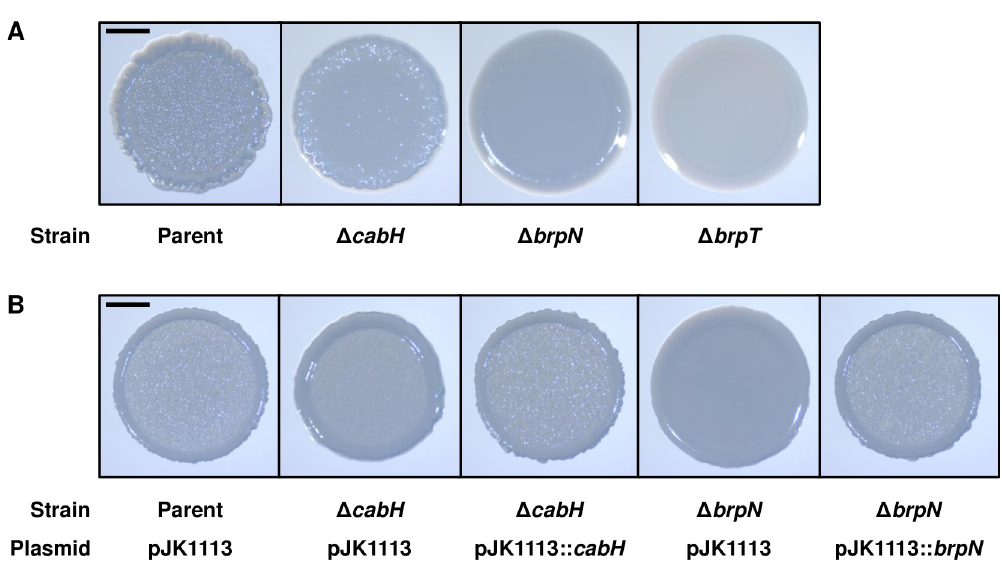
Fig 7. Colony morphology of the cabH and brpN mutants. (A, B) The V . vulnificus strains were spotted onto VFMG agar supplemented with 0.02% arabinose (A) or 0.02% arabinose, 100 μ g/ml kanamycin, and 100 μ g/ml ampicillin for complementation experiments (B) and incubated for 24 h. Each colony representing the mean rugosity from at least three independent experiments was visualized using a stereomicroscope (Stemi 305, Zeiss). All images are shown at the same scale, and 1-mm scale bars are shown on the images of the parent strain. Parent and Parent (pJK1113), parent strain; Δ cabH and Δ cabH (pJK1113), cabH mutant; Δ brpN and Δ brpN (pJK1113), brpN mutant; Δ brpT , brpT mutant; Δ cabH (pJK1113:: cabH ) and Δ brpN (pJK1113:: brpN ), complemented